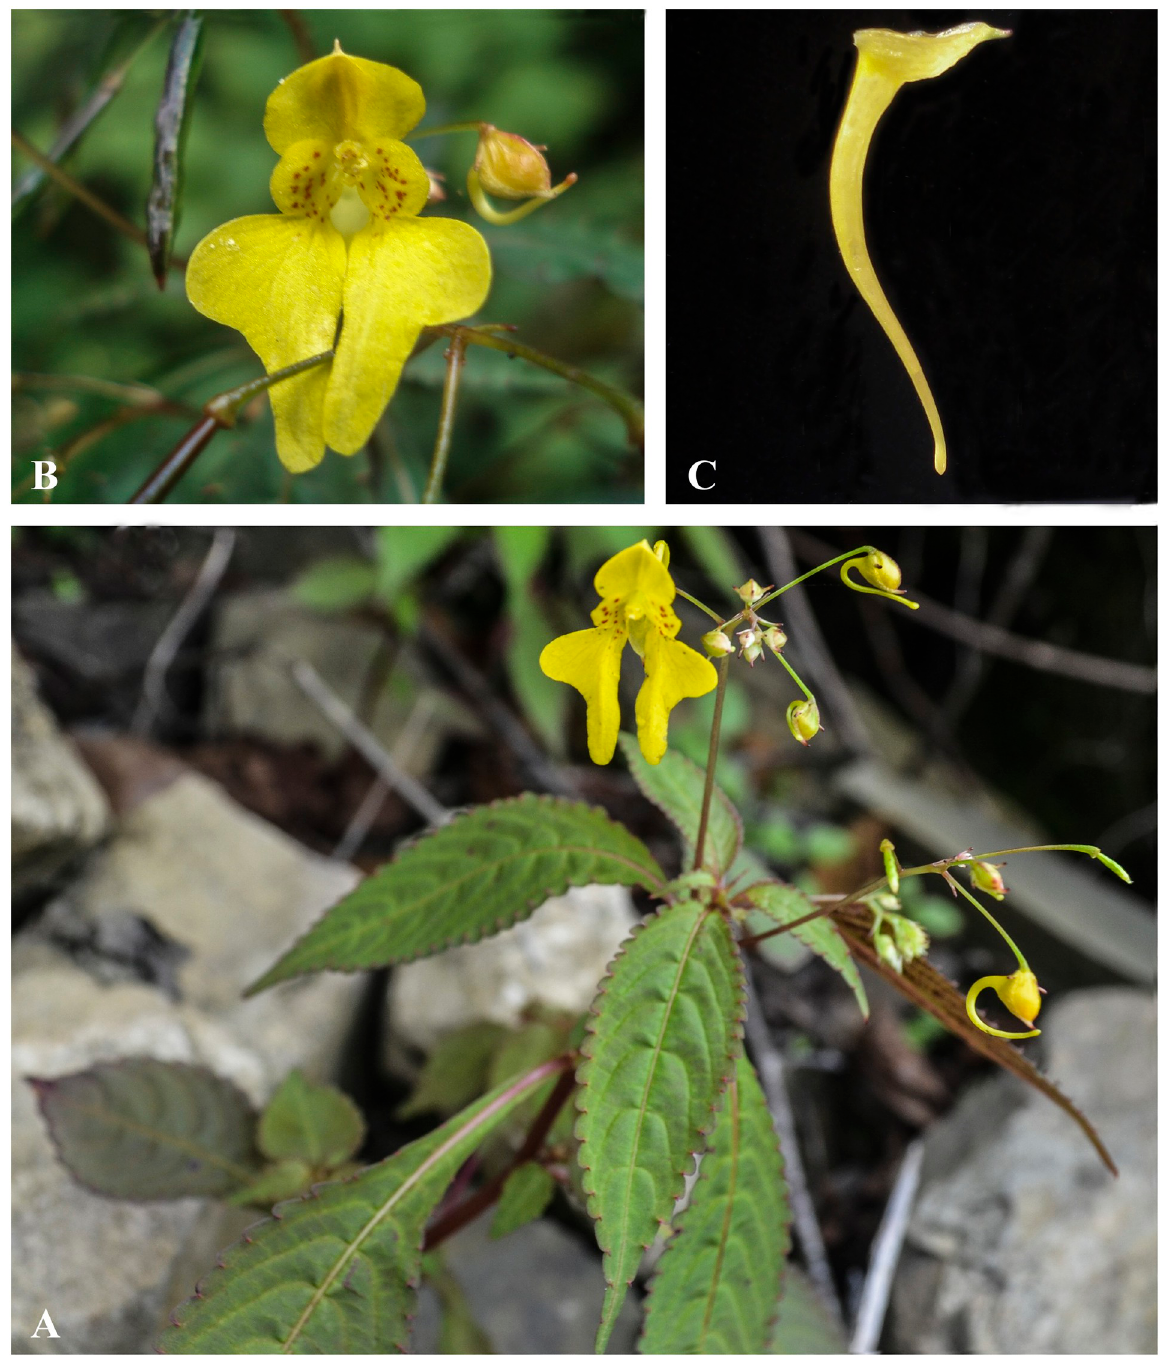
Fig 21. Impatiens racemosa A. Flowering plant; B. Flower (Front view); C. Lower sepal (side view). Photographs by Bhakta Bahadur